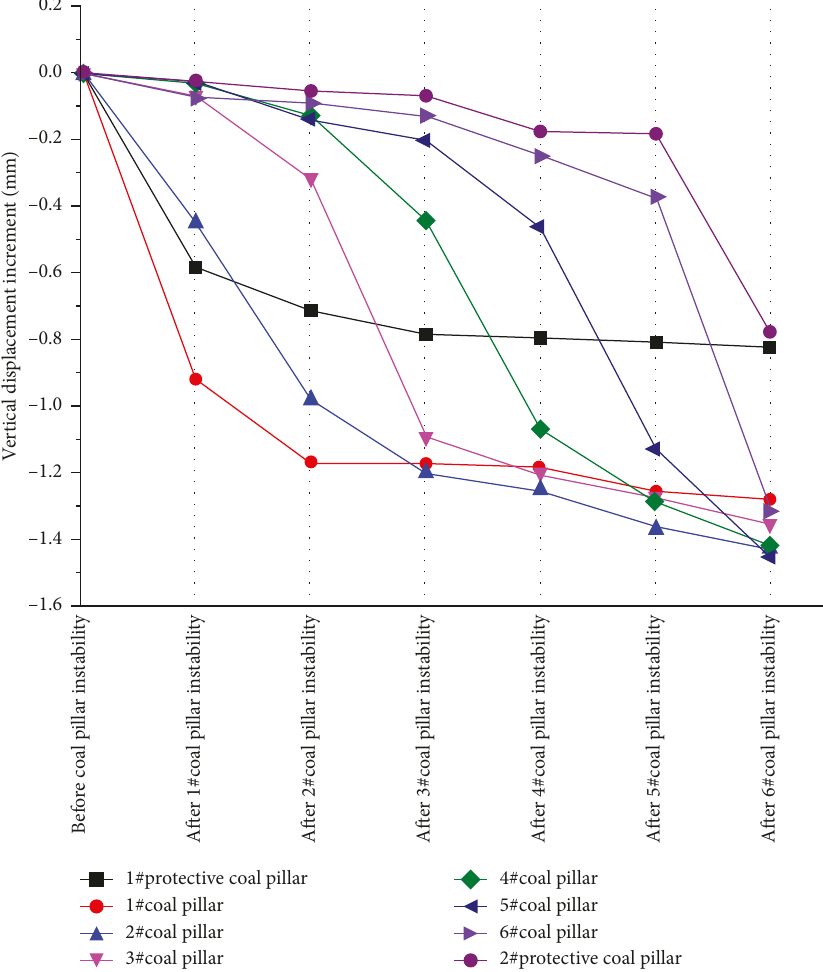
Figure 14: Displacement of measuring points above the coal pillars online L3 after the instability of coal pillars.